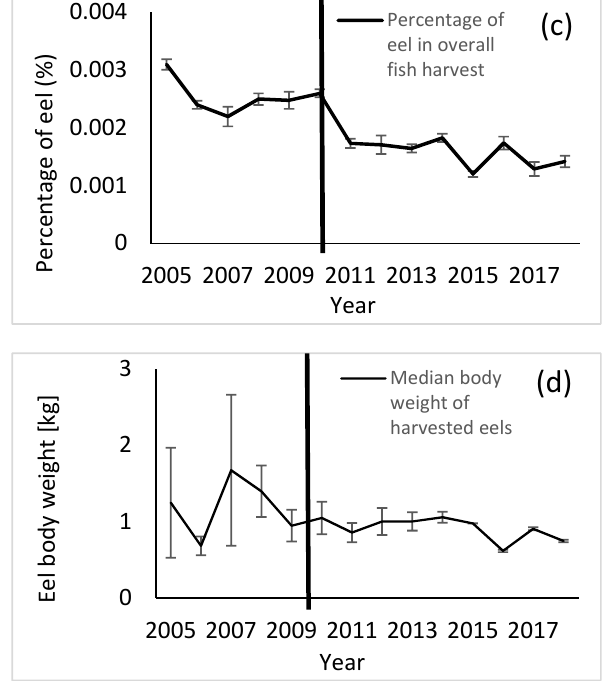
Figure 2. The European eel yields and stocking rates over the years 2005–2018 (with standard errors of means) in Prague and central Bohemia. The thick black line in the middle of each graph represents the year 2011, when the minimum legal angling size was increased from 45 cm to 50 cm (TL). The figure describes the changes in (a) the biomass of stocked eels, (b) the yield of eels, (c) the percentage of eel in the overall fish harvested, and (d) the size of eels harvested.